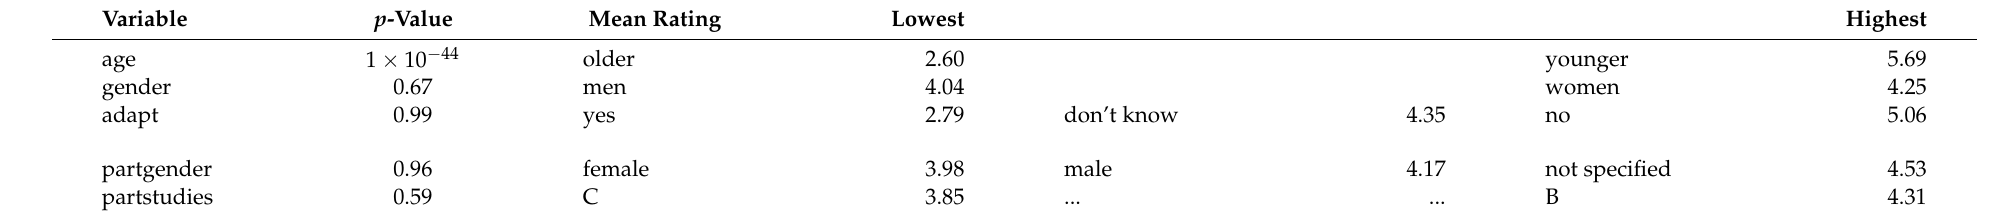
Table A8. Expertise with Smartphone (SP), p -value from ANOVA with associated mean